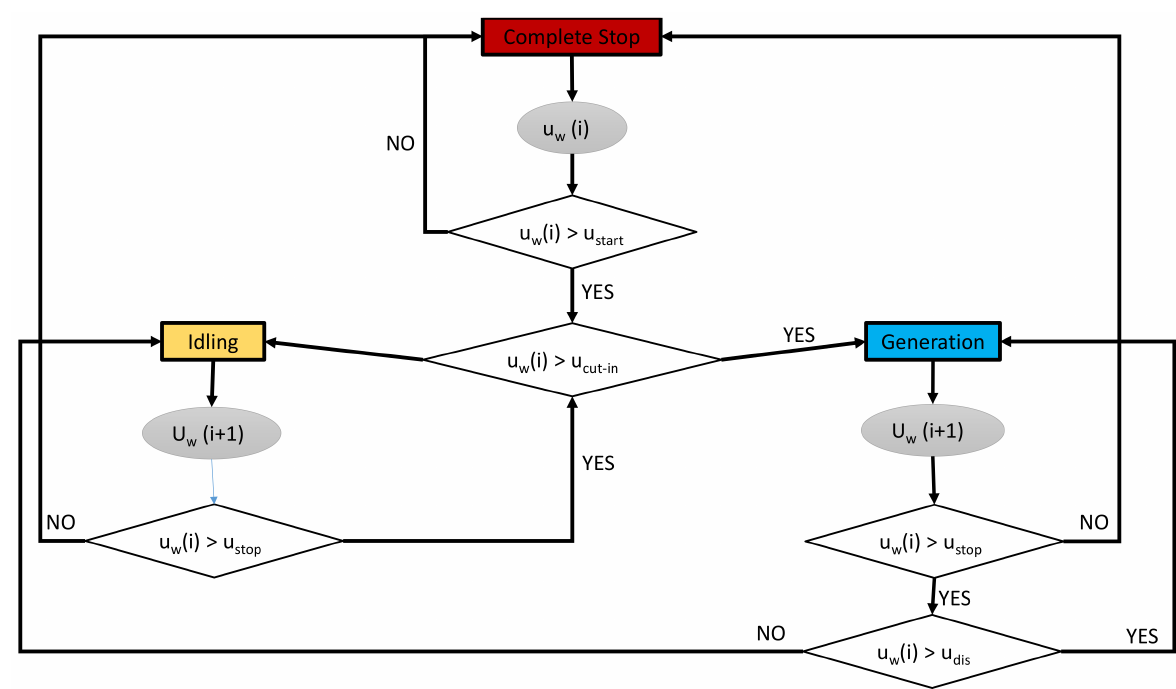
Figure 22. Flow diagram for idling state assessment.